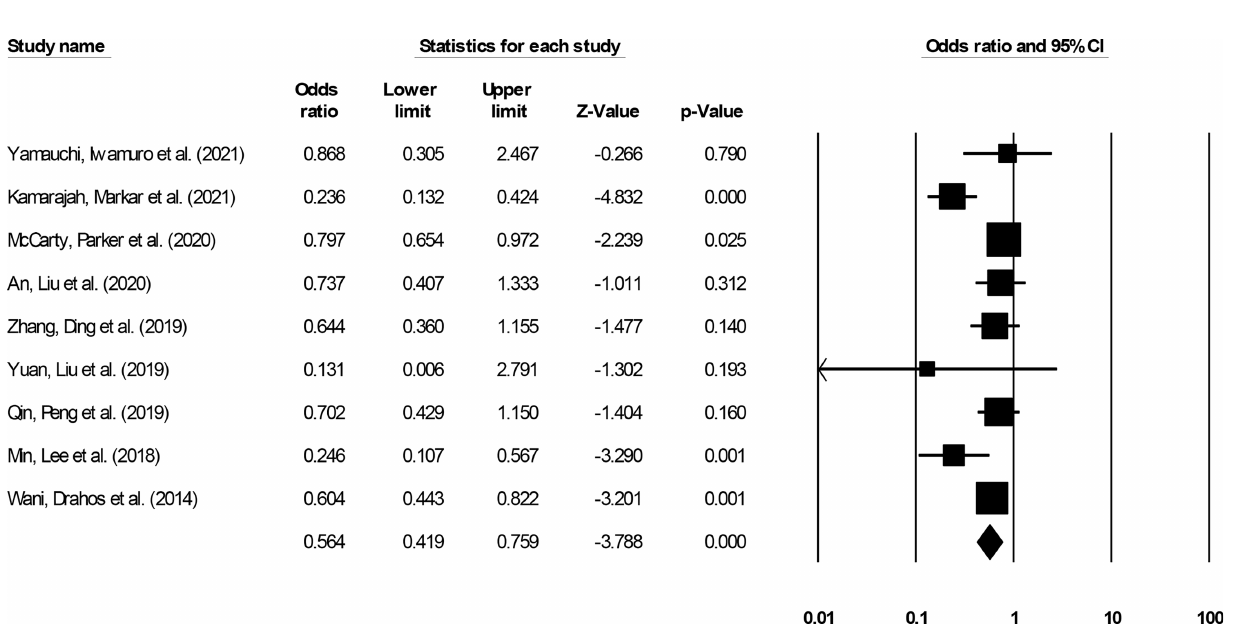
FIGURE 8 | The forest plot for studies evaluating the all-cause mortality incidence in patients with super fi cial esophageal squamous cancer undergoing endoscopic submucosal dissection or esophagectomy. The odds ratios are presented as black boxes whereas 95% con fi dence intervals are presented as whiskers. A lower odds ratio represents higher risks of all-cause mortality for patients receiving endoscopic submucosal dissection, and a higher odds ratio represents higher risks of all-cause mortality for patients receiving